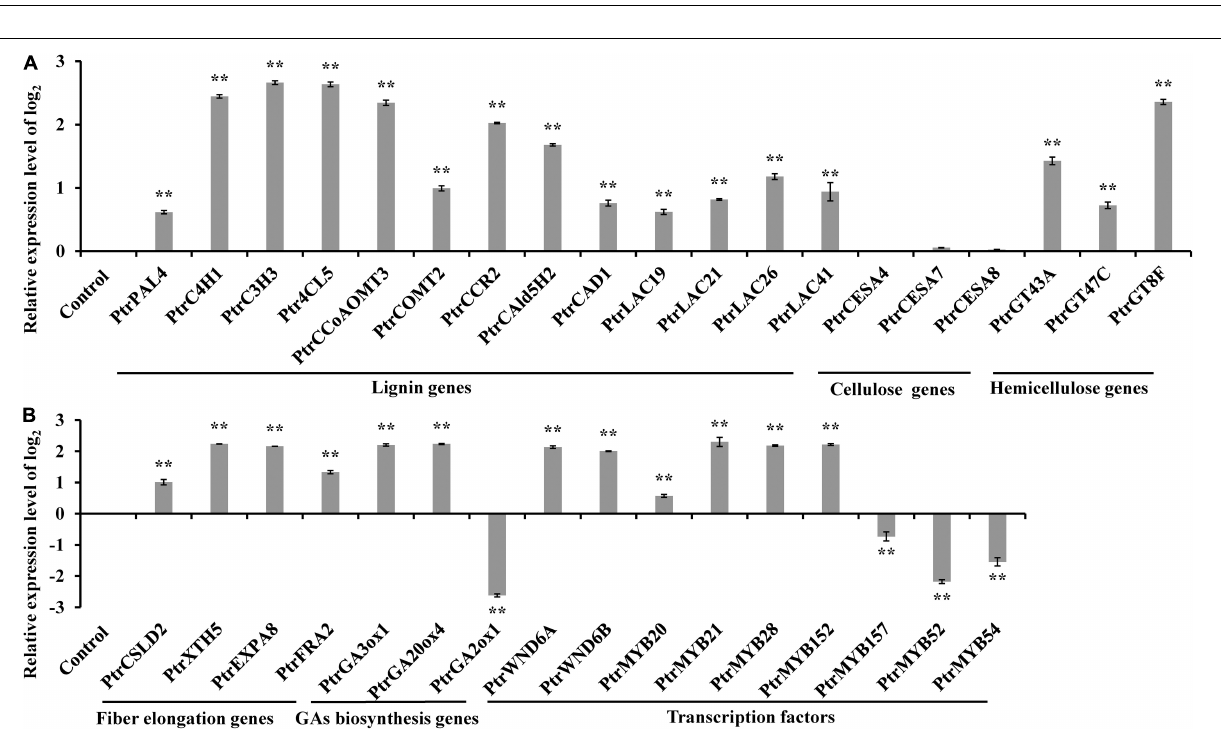
FIGURE 6 | Expression analysis of wood formation pathway genes and their regulatory genes in 90 days old wild-type and PtrWOX13A transgenic lines. (A) Represents expression analysis of lignin biosynthesis genes, cellulose biosynthesis genes, and hemicellulose biosynthesis genes. (B) Represents expression of fiber cell elongation genes, GA biosynthesis genes, and TFs. PtrActin was used as a reference gene. Control represents the normalized expression level (namely 0 in this case) of each gene examined in wild type plants. Each error bar represents the standard deviation of three biological replicates. Asterisks indicate levels of significance (Dunnett’s test; ** p < 0.01, highly significant). Those genes include lignin biosynthesis genes ( PtrPAL4 , PtrC4H1 , PtrC3H3 , Ptr4CL5 , PtrCCoAOMT3 , PtrCOMT2 , PtrCCR2 , PtrCAld5H2 , and PtrCAD1 ), lignin polymerization genes ( PtrLAC19 , PtrLAC21 , PtrLAC26 , and PtrLAC41 ), cellulose biosynthesis